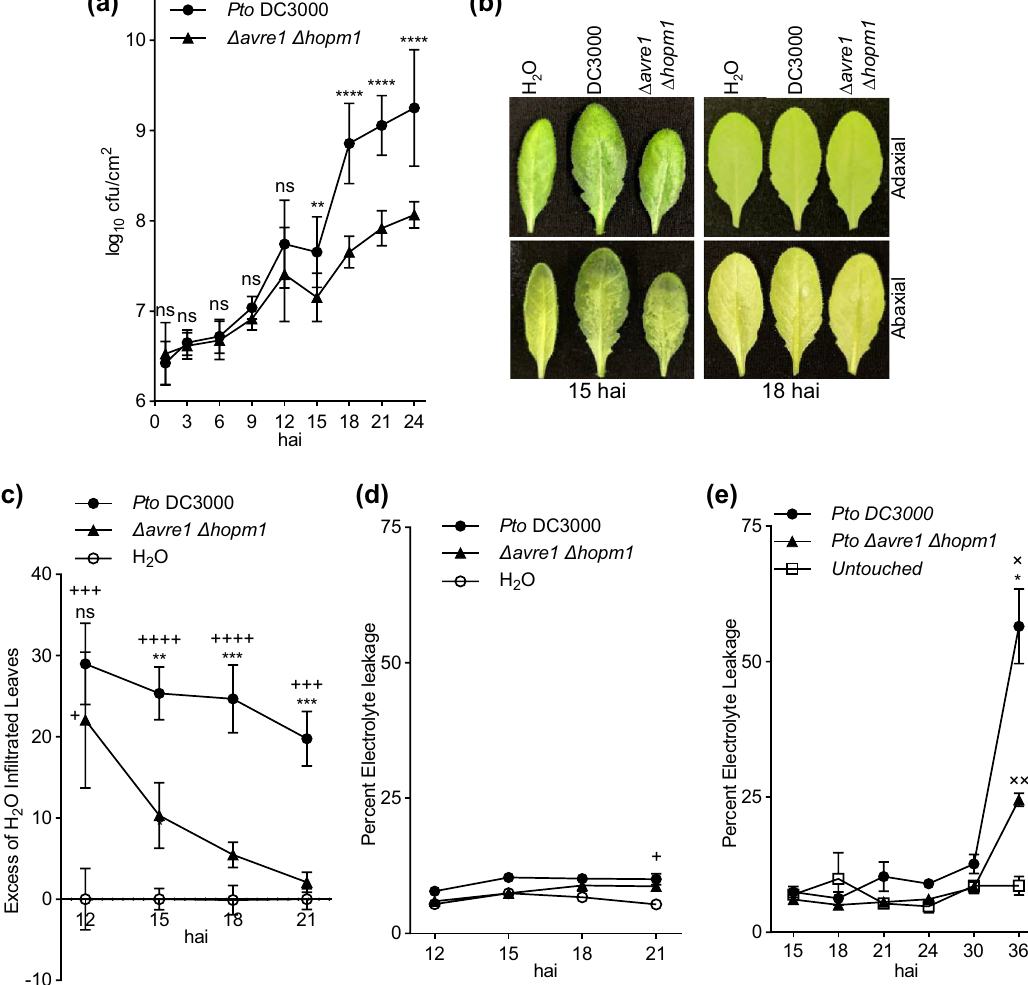
Figure 3. Timing of AvrE1- and HopM1-dependent bacterial growth, water-soaking, apoplast hydration, and loss of plant cell integrity. ( a – e ) Leaves of 5 week-old Col-0 plants were syringe-infiltrated with Pto DC3000 or ∆avre1 ∆hopm1 (at OD 600 = 0.2) or with sterile Milli-Q water. ( a ) Bacterial growth over time was assessed by serial dilution plating as log 10 colony-forming units (cfu) per leaf area. For each experiment, n = 6 samples/ bacteria/time point, with each n consisting of 2 leaf discs taken from 2 different leaves. The experiment was performed 4 times and combined data (n = 24) is shown. ( b ) Representative images of the abaxial and adaxial surfaces of leaves at 15 and 18 hai. ( c ) Apoplast hydration was measured at the indicated time points and is presented as percent apoplast hydration in excess of water treated leaves. For each experiment, n = 3 samples/ treatment/time point, with each n consisting of 9 leaves taken from 3 different plants. The experiment was performed 5 times and combined data (n = 15) is shown. ( d ) Percent electrolyte leakage from samples of Fig. 3c. For each replicate, n = 3 samples/treatment/time point, with each n consisting of 2 punches taken from 2 different leaves. Shown is combined data from four of the five replicates (n = 12). ( e ) Percent electrolyte leakage over a longer time course than in Fig. 3c. For each experiment, n = 3 samples/treatment/time point, with each n consisting of 2 punches taken from 2 different plants. Combined data from two experiments (n = 6) are shown. Values are means ± SEM and statistically significant differences are based on Welch’s t-test. For comparisons between Pto DC3000 and ∆avre1 ∆hopm1 ; **** p < 0.0001; *** p < 0.0009; ** p < 0.005; * p < 0.05. For comparisons of bacterial strains and H 2 O; + + + + p < 0.0001; + + + p < 0.0009; + + p < 0.005; + p < 0.05. For comparisons of bacterial strains and untouched; × × p < 0.005; × p <